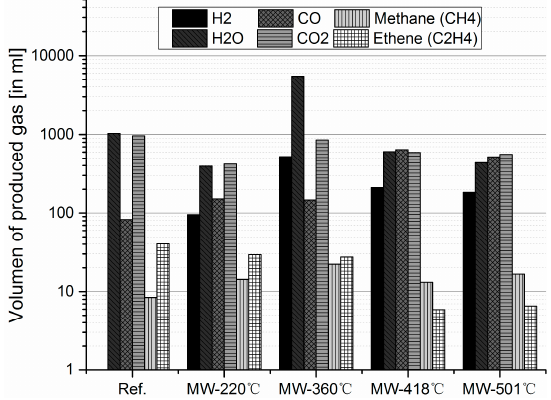
Figure 11. Volume of light molecules generated at different target temperatures with microwave heating.